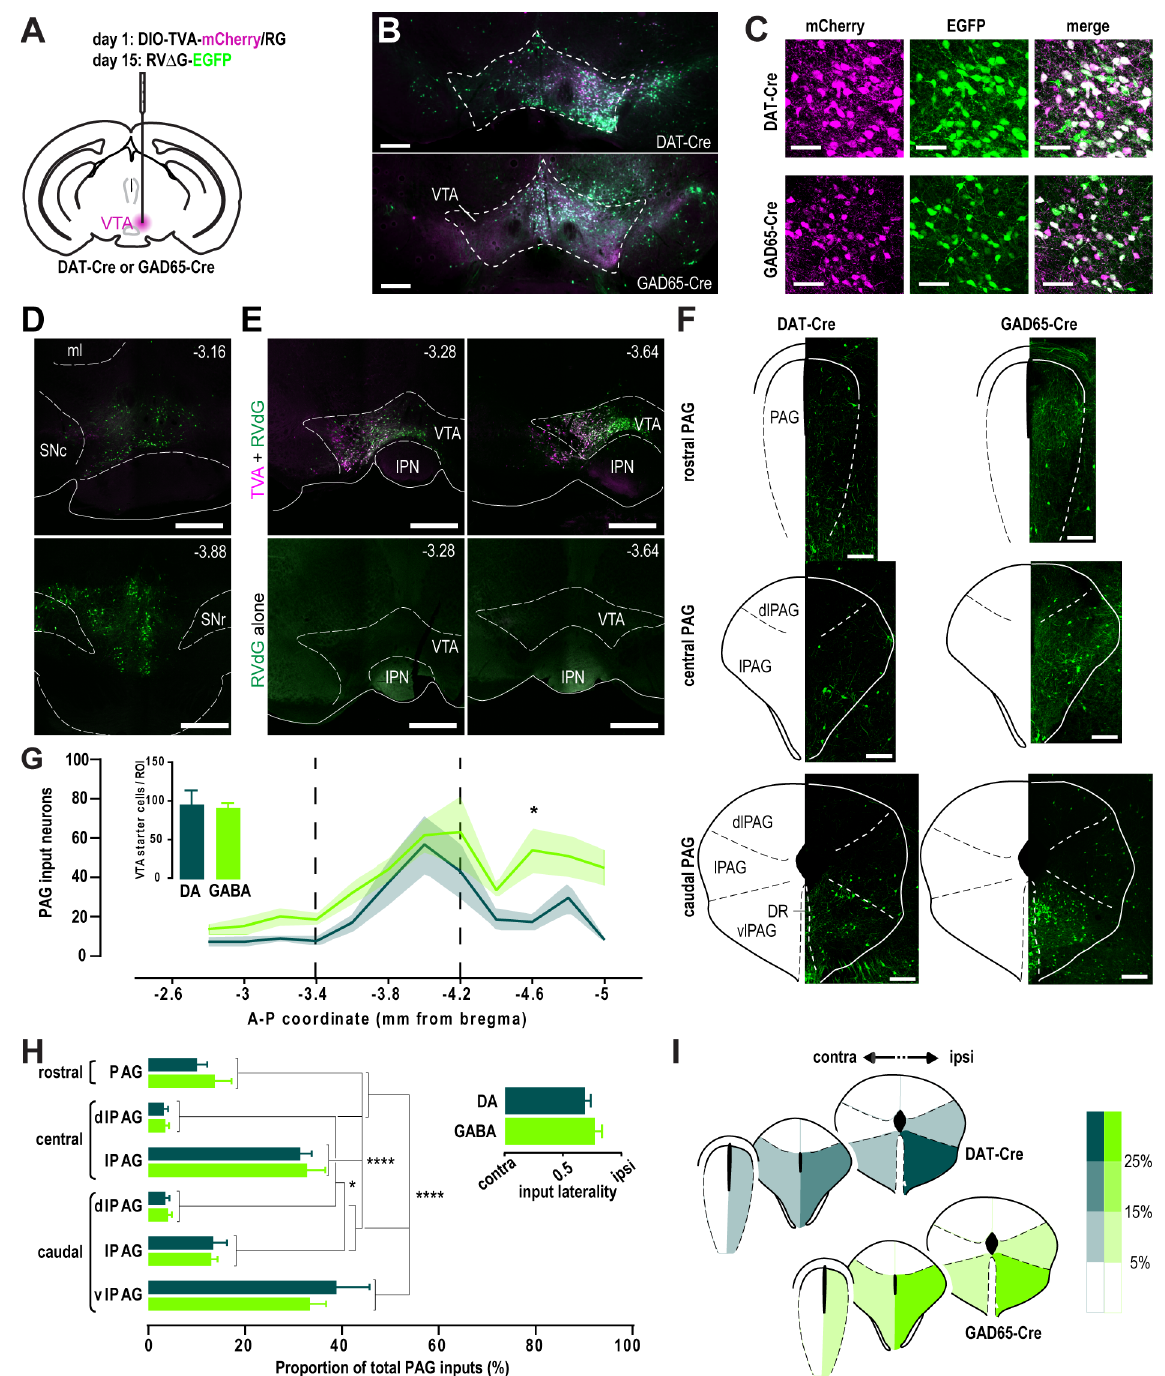
Fig 1. Spatial distribution of VTA-projecting PAG inputs. A, Schematic of the unilateralrabies injectionprotocol. B-C, Confocal images at low (B) and high(C) magnification showingthe expressionof TVA-mCherry (magenta) and RV Δ G-EGFP (green) in the VTA seven days after the last injection. Scale bars, 500 μ m (B) and 50 μ m (C). D, Representative confocalimages showing confined starter cell infection(i.e. TVA-mCherry and RV Δ G-EGFP co-expression) in coronal sections rostral (top) or caudal(bottom) to the VTA of a DAT-Cre mouse. Antero-posterior coordinates(in mm) from Bregma are shown on the top right corner. Scale bars, 500 μ m. ml, medial lemniscus; SNc, substantianigra pars compacta; SNr, substantianigra pars reticulata. E, RV Δ G-EGFP alone was not able to infect neuronswithout TVA-mCherry expression. Antero-posterior coordinates(in mm) from Bregma are shown on the top right corner. Scale bars, 500 μ m. IPN, interpeduncular nucleus. F, RV Δ G-EGFP-expressing retrogradely labeledinput